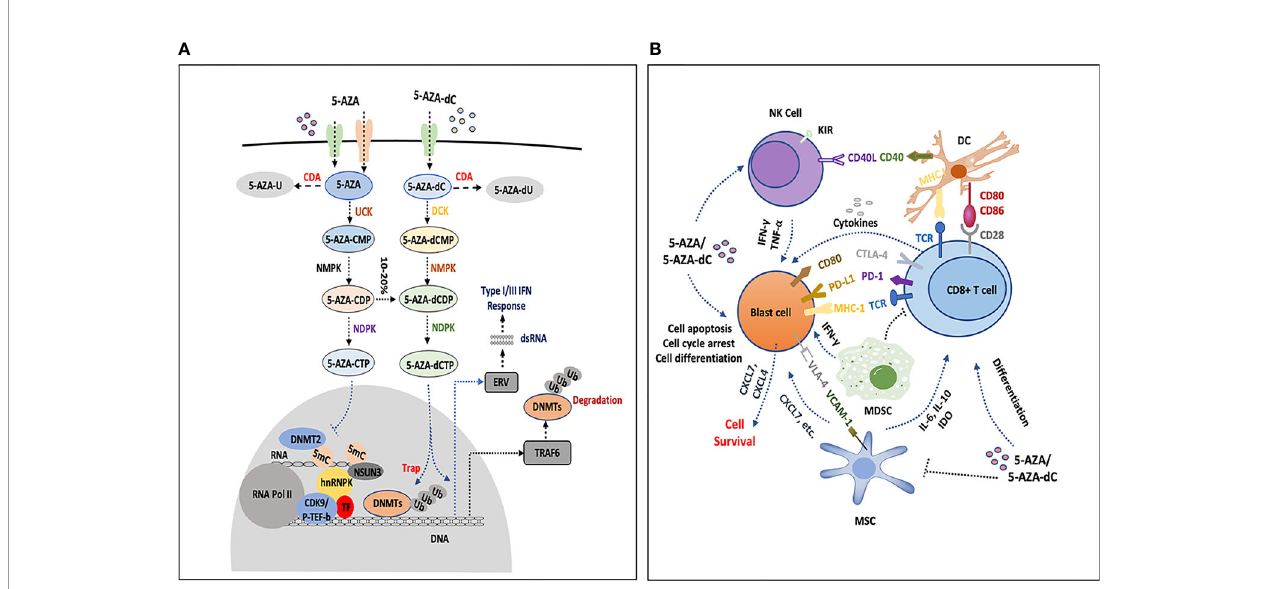
FIGURE 1 | The in fl uence of HMAs on bone marrow cells. (A) 5-AZA and 5-AZA-dC are transported into blast cells or immune cells (T cells, NK cells and DCs) by hENT1, hENT2, and hENT1-2, hCNT1 and hCNT3, respectively, part of which are catalyzed by CDA and result in degradation. The remaining AZA and 5-AZA-dC are catalyzed into 5-AZA-CMP and 5-AZA-dCMP by UCK and DCK, separately. In the following process, NMPK and NDPK play a role in the formation of 5-AZA- CTP and 5-AZA-dCTP. 5-AZA-CTP is mainly incorporated into RNA and possibly promotes the formation of 5-AZA sensitive chromatin structure, which consists of hnRNPK, DNMT2, NSUN3, CDK9/p-TEF-b and TF. 5-AZA-dCTP depletes DNMTs and increases gene expression, degradation of DNMTs is processed by proteosome pathway or by upregulating TRAF6 that leads to DNMTs ubiquitination, 5-AZA-dCTP is also activated and becomes hydrolyzed by SAMHD1 in leukemia. Simultaneously, 5-AZA-dCTP activates the transcription of ERV, induces dsRNA formation and facilitates type III interferon response. (B) 5-AZA-dC and 5-AZA inhibit NK cells by upregulating the inhibitory receptor KIR, or activate the antitumor activities by secreting some cytokines (IFN-Gamma or TNF-Alpha). HMAs induce the expression of CD40 and CD86 on DCs, which interact with CD8+ T cells by CD80/86-CD28 and TCR-MHC I CD8+ T cells communicate with blast cells by TCR-MHC I, PD-1-PDL1, and CTLA-4-CD80. HMAs increase the secretion of IFN-Gamma and antitumor activity of CD8+ T cells, and the expression of PD-1 and CTLA4 is upregulated as well, which participate in immune suppression. HMAs decrease the percentage of MDSCs in the bone marrow, which may promote the function of HMA. MSCs secrete IL-6, IL-10, IDO-1, etc., to inhibit CD8 T cells or directly interact with blast cells by VCAM1-VLA4. Leukemia cells express high level of CXCL4 and CXCL7 to promote the survival of leukemia cells under the treatment of HMAs. MSC can also secret CXCL7. These interactions and secretion of chemokines or cytokines in the bone marrow, which potentially mediate the resistance to HMAs, are still not completely